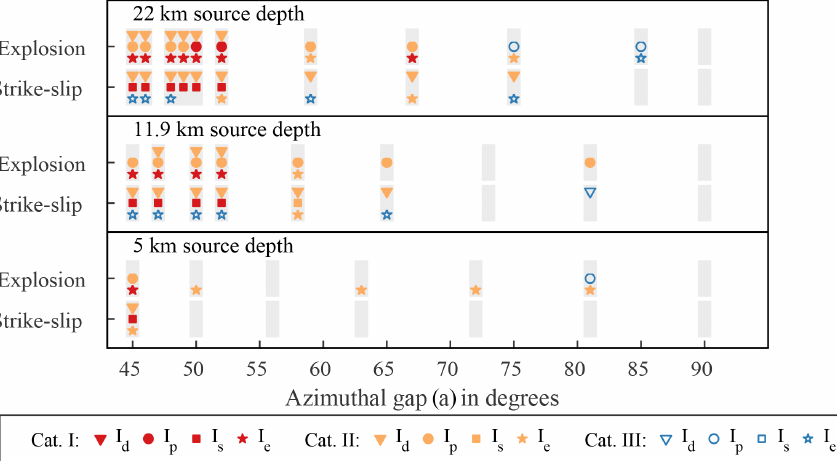
Figure 10. The location accuracy achieved with different maximum azimuthal gaps ( a ). Three source depths were tested for the two source types, respectively. The locations obtained with the individual imaging conditions were ranked according to the categories from Fig. 2. Grey bars indicate set-ups that were tested. No symbol in the grey bar means that the localisation was unsuccessful. Symbol types and colours in the grey bars represent successful locations with the imaging condition sorted into the respective category.